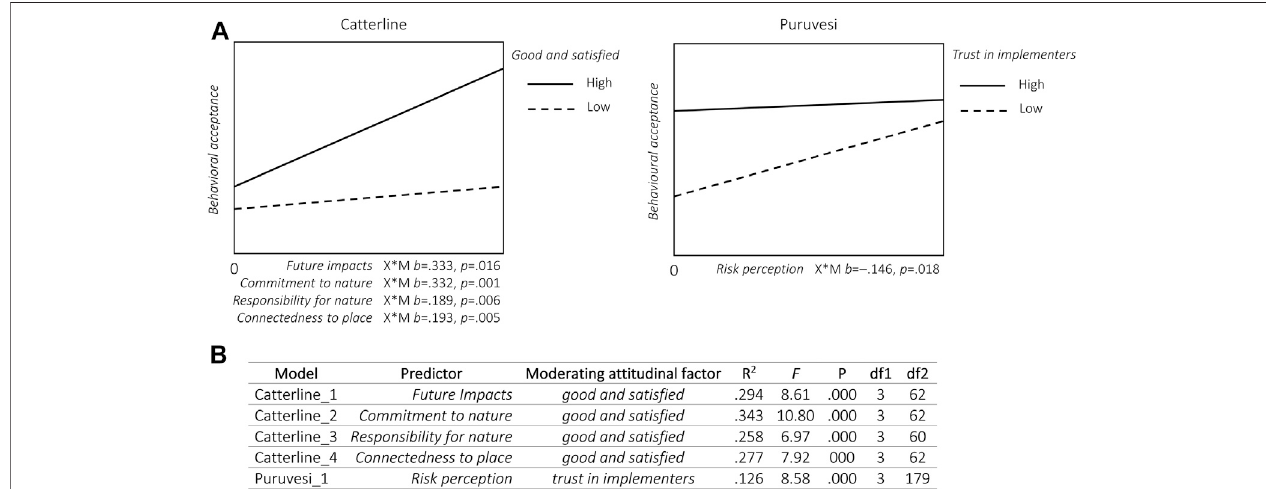
FIGURE 5 | Schematic representations of statistically signi fi cant ( p < 0.05) moderating attitudinal acceptance factors in Catterline and Puruvesi (A) and model statistics (B) .Thesefactors(M)moderaterelationsbetweentherisk,nature,andplacepredictorsurveyvariables(X)and behavioralacceptance .Forexample,inPuruvesi there is a signi fi cant positive relation between risk perception and behavioral acceptance , but this relation is signi fi cantly stronger when respondents ’ scores on the attitudinal factors trust in implementers is low. These are schematic representations of relations. Further statistical output and graphs are provided under Supplementary Table S7